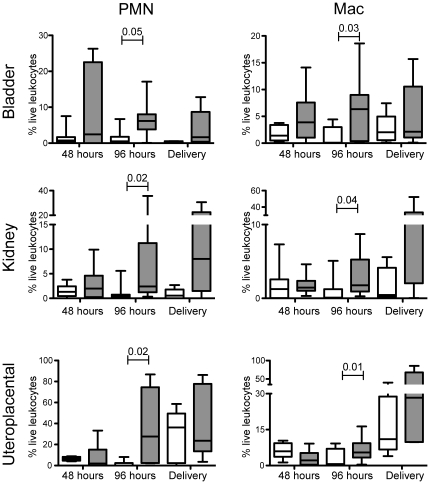
PMN and macrophage infiltration in uteroplacental tissues.The magnitude of the particular cell type of interest is reported as a percentage of live leukocytes within each individual organ indicated from pregnant mice that received sham infection (white) or experimental UTI (gray) at 48 h (10 mice each cohort), 96 h (10 mice each cohort), and delivery (8 mice each cohort). Abbreviations: PMN, polymorphonuclear neutrophil; Mac, macrophage. Bars indicate standard deviation. Statistical significance determined using a two-tailed Mann-Whitney for internal comparisons within each time point indicated in each panel.